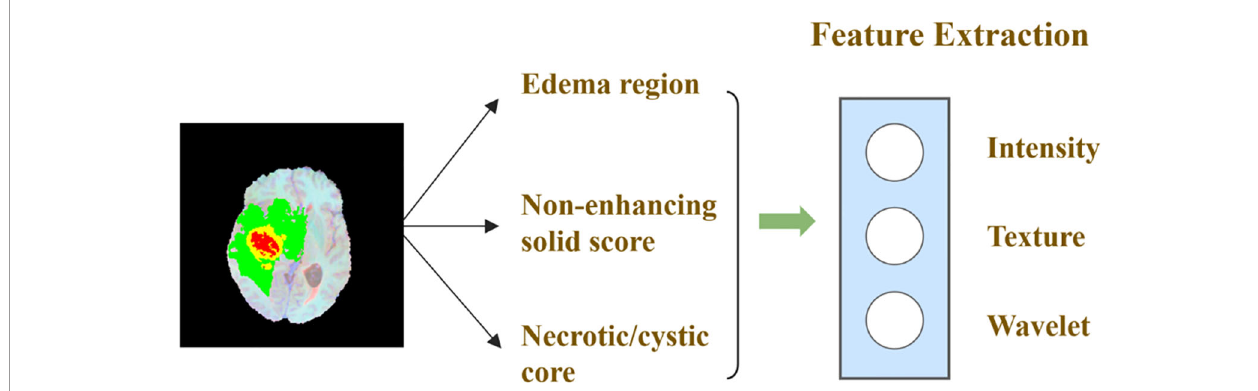
FIGURE 7 | Schematic diagram of image feature